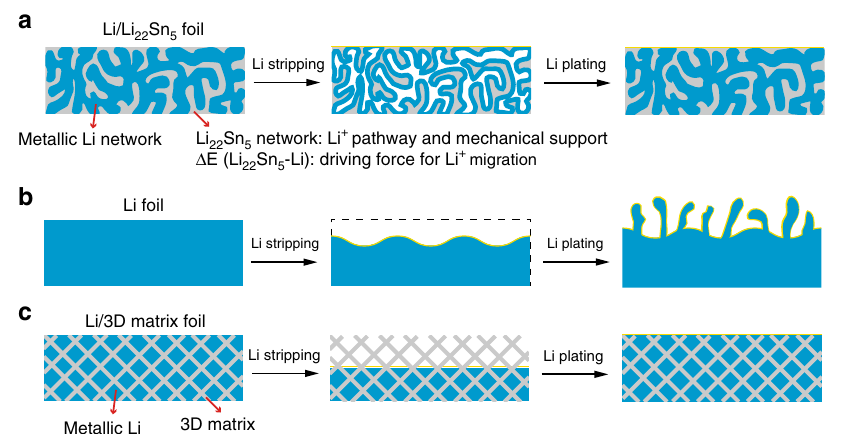
Fig. 5 Schematic of lithium stripping/plating process of Li/Li 22 Sn 5 nanocomposite foil, lithium foil, and Li metal with 3D matrix (Li/3D matrix). In the Li/Li 22 Sn 5 foil, the in situ formed nanostructured 3D Li 22 Sn 5 and metallic lithium network interconnect with each to form an integrated structure with abundant Li/Li 22 Sn 5 interfaces with low interface impedance due to the good af fi nity between Li 22 Sn 5 and metallic lithium. The 3D Li 22 Sn 5 network works as a lithium diffusion and electron transfer “ pathway ” and its potential difference with metallic lithium provides the driving force for lithium diffusion. Thus, the stripping and plating of metallic lithium metal takes place over the entire Li/Li 22 Sn 5 electrode ( a ). The pristine lithium metal foil electrode shows inhomogeneous lithium stripping and plating behavior and dendrite growth takes place during cycling ( b ). For the Li metal anode with “ non-lithium ion conductive ” 3D matrixes, the dissolution of lithium metal starts on the top or surface of the composite electrode during the lithium stripping process. Metallic lithium deposits back into the 3D porous structure during the lithium plating process ( c